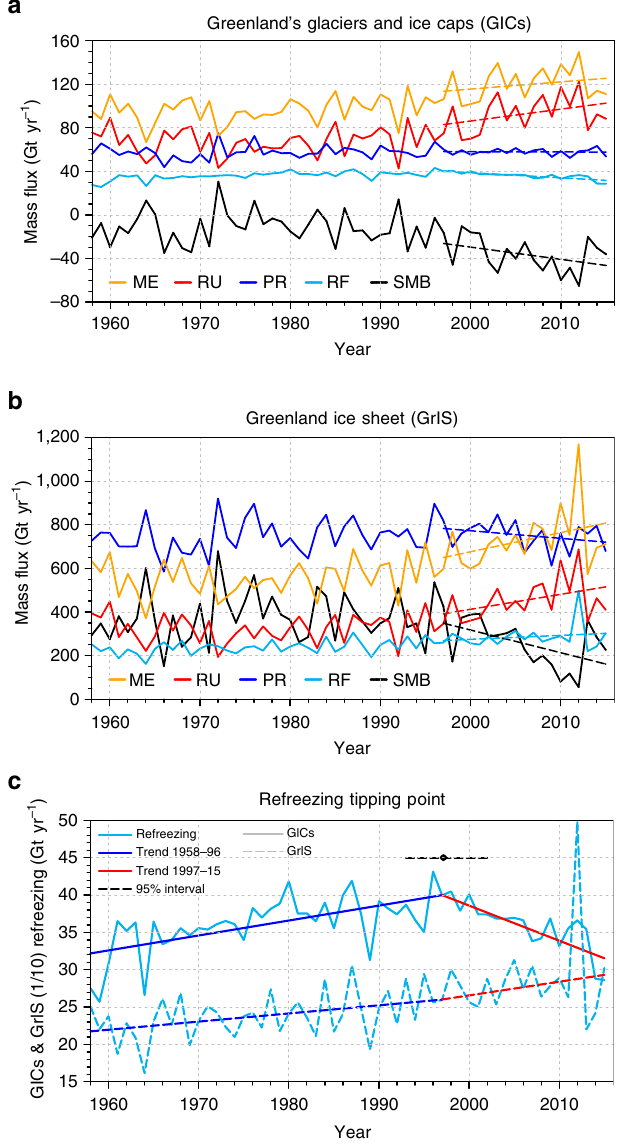
Figure 3 | Mass flux evolution and refreezing tipping point. ( a ) Time series of GICs annual cumulative SMB components for the period 1958–2015. ( b ) Same as a but for the contiguous GrIS. Dashed lines show 1997–2015 trends. Total sublimation (SU) and snow drift erosion (ER) are not included in the above time series as they contribute relatively little to SMB and trends are very small compared to the other components. ( c ) Time series of GICs (continuous lines) and GrIS (1/10, dashed lines) integrated annual mean refreezing and trends for 1958–1996 (blue) and 1997–2015 (red). The GICs refreezing tipping point (1997) is represented in black with a 95% confidence interval (dashed black